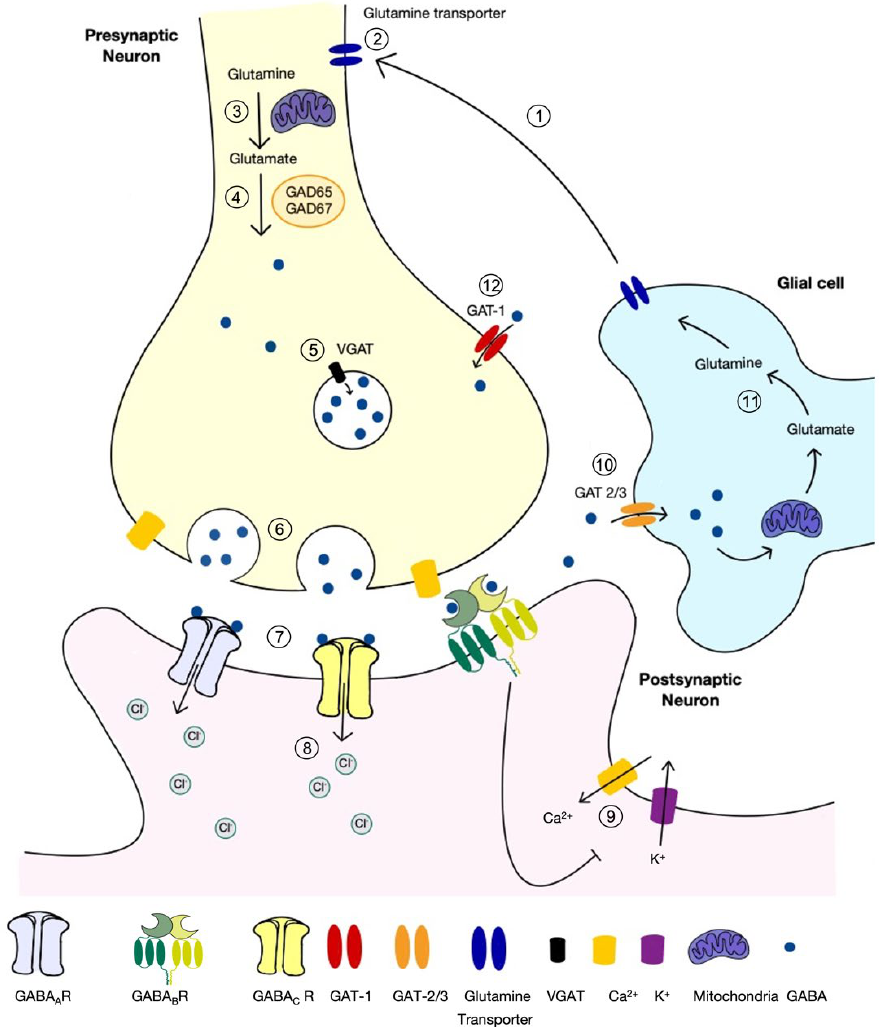
Figure 1. The mechanism of GABAergic neurotransmission. GABA is synthesised in the cytoplasm of the presynaptic terminal by GAD65 or GAD67 from glutamate supplied by adjacent glial cells via uptake of glutamine by the glutamine transporter and conversion to glutamate (1 to 4). GABA is then loaded into synaptic vesicles by VGAT (5) and released into the synaptic cleft via vesicle exocytosis (6). GABA can then bind to ionotropic GABA A or GABA C receptors (7), directly activating Cl − flux across the postsynaptic membrane (8), or to metabotropic GABA B receptors, indirectly activating Ca 2+ or K + ion channels via second messenger signalling (9). GABA is taken up from the synaptic cleft into glial cells via GAT 2/3 (10) for breakdown into glutamine (11) or into the presynaptic terminal via GAT-1 for recycling into synaptic vesicles (12).